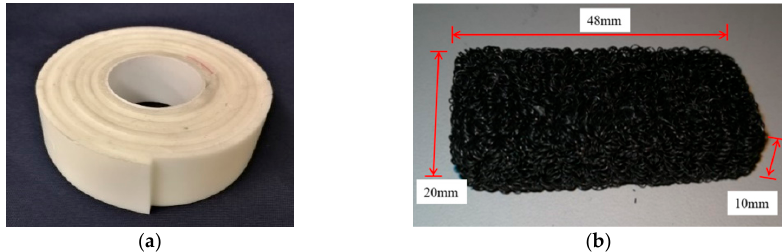
Figure 4. Energy dissipating materials used in PTMD: ( a ) Viscoelastic (VE) material; ( b ) shape